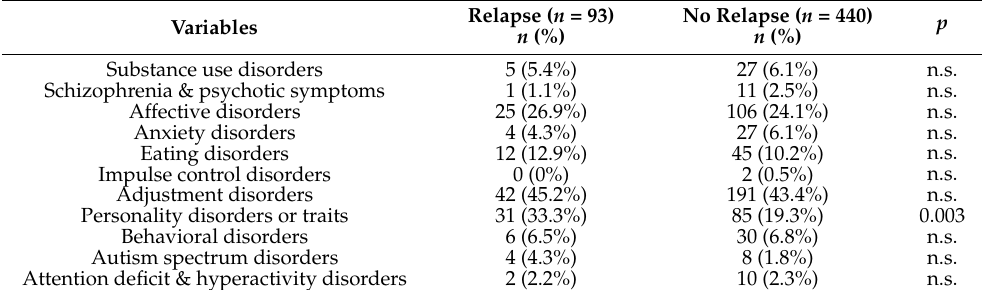
Table 2. Diagnosed psychopathology of the sample.